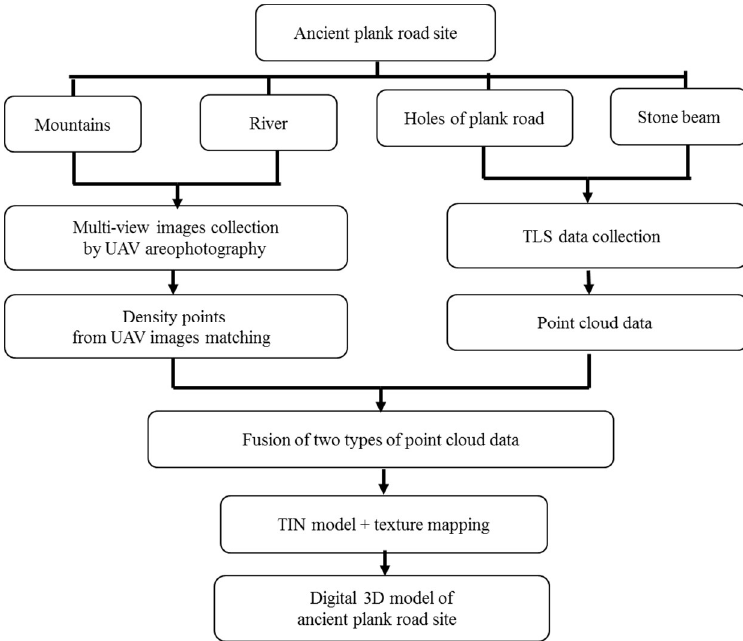
Figure 4. Designing a process for the digital model for the ancient plank road